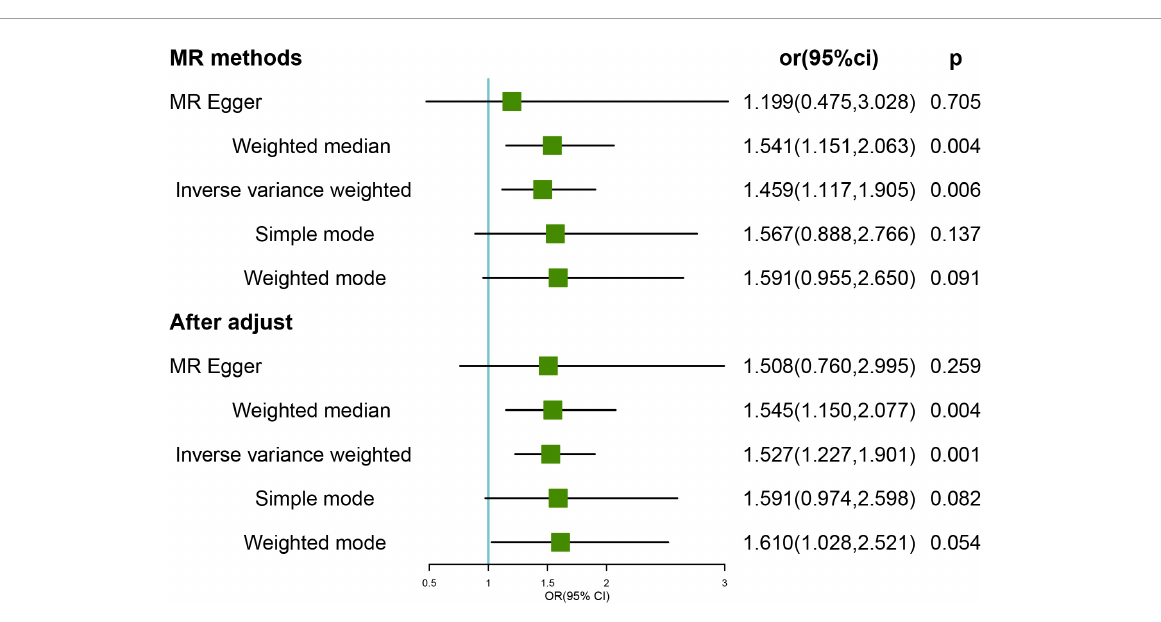
FIGURE2 Mendelian randomization (MR) results for genetically predicted hearing loss (HL) and frailty index (FI). OR, odds ratio; CI, confidence interval. After adjust: after removing the four outlier SNPs (rs34656207, rs741475, rs10901863, rs1126809, rs1566129, and